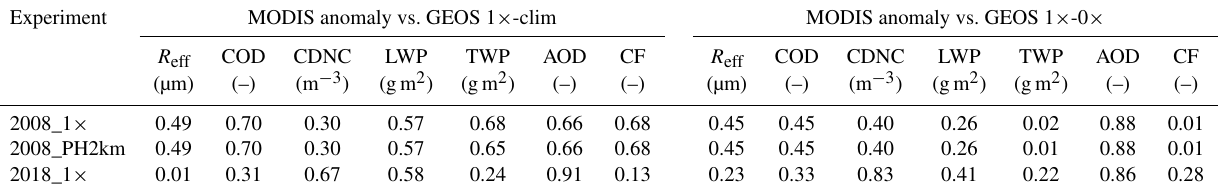
Table 4. R 2 values for the comparison of GEOS normalized zonal anomalies for liquid clouds against MODIS.